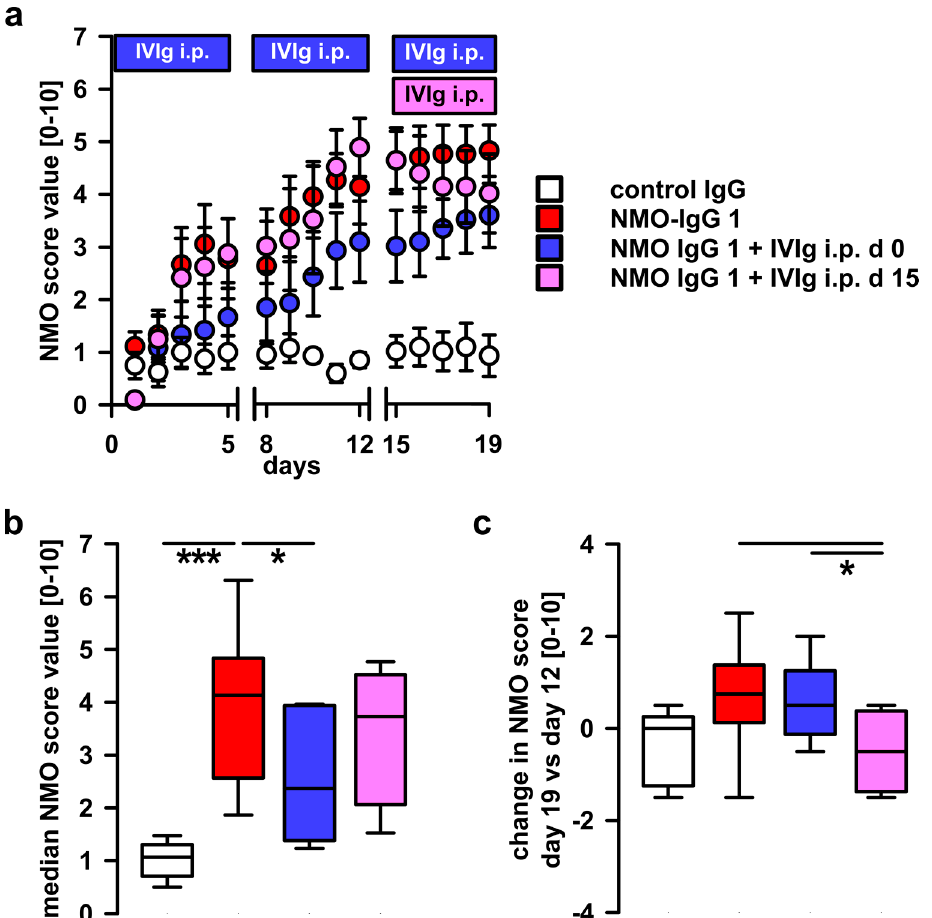
Figure 2. Effects of preventive and therapeutic systemic injections of IVIg. ( a ) Repetitive i.th. injections of NMO-IgG 1 led to development of disease symptoms (NMO score). The NMO-score of the NMO-IgG injected animals (red circles) increased over the experimental period and reached a plateau phase at the end of i.th. injections. The progression of the disease was slowed by concurrent i.p. application of IVIg (blue circles). Rats of the therapeutic IVIg group, receiving IVIg i.p. later, i.e., starting at day 15 (purple circles), developed comparable disease symptoms as the animals of NMO-IgG 1 (red) in before IVIg was given. After starting the IVIg injections on day 15, the NMO-score decreases over the 5 following injection days. Control IgG injected animals showed only minor abnormalities from the start (white circles). Breaks on the X-axis indicate 2 day-pauses of NMO-IgG injections. Two-way ANOVA with Bonferroni post hoc tests revealed significant differences of all groups vs. the group receiving control IgG ( p < 0.001) and the group of NMO 1 vs. NMO1 + IVIg i.p. day 0 ( p < 0.001); ( b ) the median NMO-score determined from the score values over the entire experiment were significantly lower when i.p. injections of IVIg were given prophylactically (one-way ANOVA, Bonferroni post hoc test; * p < 0.05; *** p ≤ 0.001; plots show median ± 25th and 75th percentiles with whiskers of the 5th and 95th percentiles); ( c ) the treatment group receiving IVIg in the therapeutic paradigm from day 15 showed a reduction of the NMO score beginning with the 11th injection while the NMO score still slightly increases in the untreated and the prophylactic treatment group but there it remained at a lower final score level (one-way ANOVA Bonferroni post hoc test, * p < 0.05; plots show median ± 25th and 75th percentiles with whiskers of the 5th and 95th percentiles).